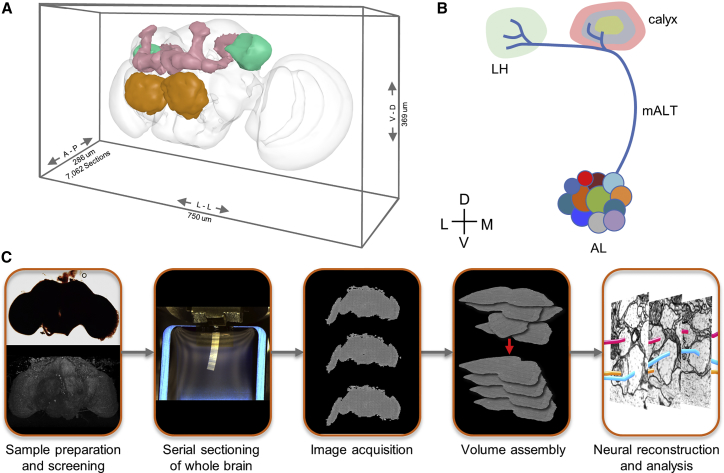
Target Volume and EM Acquisition Infrastructure(A) Oblique view of a surface model of the Drosophila brain (gray mesh) with specific neuropil compartments highlighted: AL (orange), MB (pink), and LH (green).(B) Schematic of olfactory pathway. Approximately 150 PNs, divided into ∼50 subtypes based on their anatomically defined glomeruli of origin in the AL, project to the MB calyx and LH (Grabe et al., 2016, Masse et al., 2009). Lateral horn is thought to mediate innate olfactory behaviors, whereas the MB is involved in learned behaviors (Keene and Waddell, 2007). In MB calyx, PN collaterals terminate in boutons and synapse on KCs (Yasuyama et al., 2002). Most PN types project to the MB calyx via the mALT, but several travel in secondary tracts (data not shown), and a few bypass calyx and project only to LH (Frank et al., 2015, Stocker et al., 1990, Tanaka et al., 2012).(C) Workflow for the generation of the whole-brain dataset. Blocks of brain tissue are incubated in heavy metals to label cell membranes, embedded in a resin polymer, and screened with X-ray tomography. Blocks were then serially sectioned with a diamond knife (for an introduction to serial sectioning techniques, see Harris et al., 2006). Groups of three serial sections are placed on metal slot grids for imaging in one of the two custom high-throughput TEM systems (TEMCA2 or ATPS). The imaged sections were assembled into an aligned volume with the custom software pipeline described here. Reconstruction and analyses of neural circuits in the volume were conducted with the CATMAID tracing environment (Saalfeld et al., 2009).D, dorsal; V, ventral; A, anterior; P, posterior; M, medial; L, lateral; LH, lateral horn; mALT, medial antennal lobe tract. See also Figures S1, S2, and S3 and Videos S1, S2, S3, and S4.